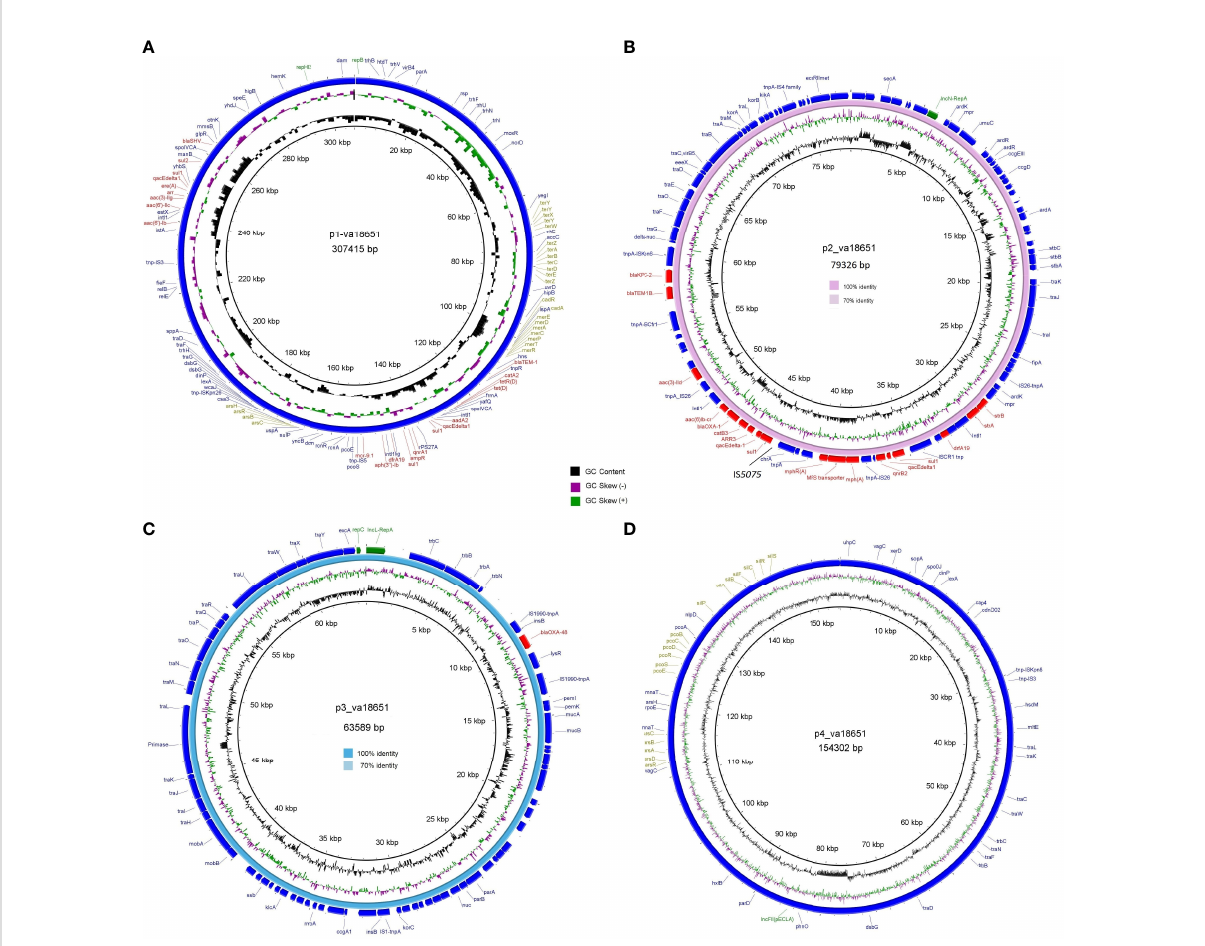
FIGURE 2 Circular genetic maps of the plasmids p1-va18651 (A) , p2-va18651 (B) , p3-va18651 (C) , and p4-va18651 (D) from the E xiangfangensis isolate va18651. Plasmid replicons, antimicrobial resistance, and heavy metal resistance are marked in green, red, and olive green, respectively. B depicts the BRIG comparison of p2-va18651 with pCP13069KPC2 (VKMZ0100118.1) and C displays the comparison of p3-va18651 with pOXA- 48_1639